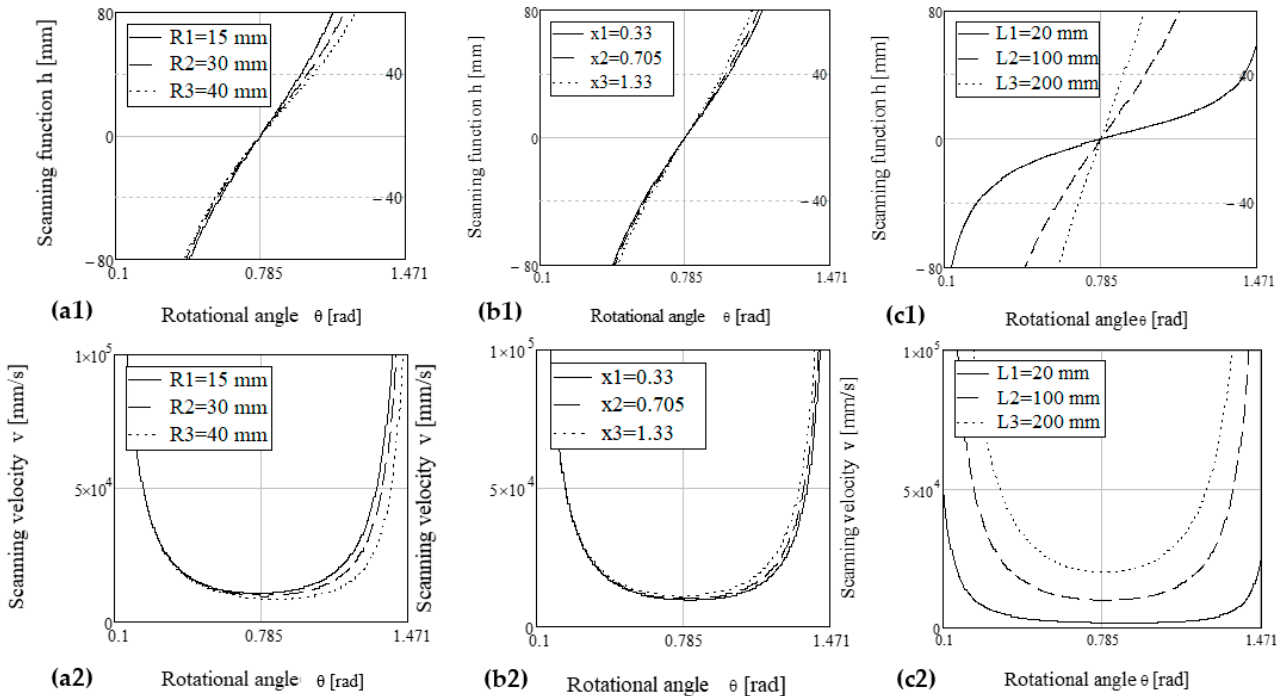
Figure 7. Study of the scanning function ( 1 ) and the scanning speed ( 2 ) of PM scanning heads with regard to their characteristic parameters: ( a ) Apothem R ; ( b ) x=e/R parameter; ( c ) length L from the fixed (vertical) incident ray to the lens.